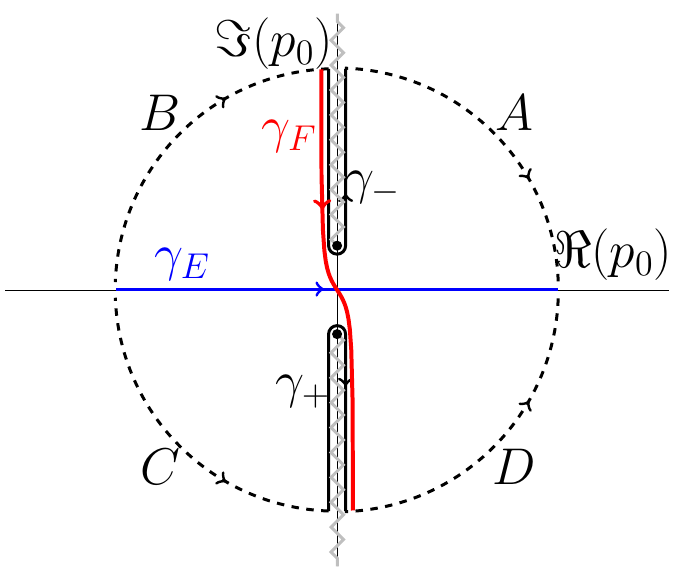
Figure 4 . Contour for would-be \Wick rotation" in the presence of branch-cuts, where p 0 is real for the Euclidean case. (cid:13) E is the contour for the Euclidean propagator, while (cid:13) F is the contour for the (+ i(cid:15) ) Feynman propagator in Minkowski space. At in(cid:12)nity, the integrals for any propagator de(cid:12)ned as a function of p 2 , obey B = D = (cid:0) A (cid:3) and C = A . Equating the Euclidean propagator (cid:1) with the semi-circular integrals taken above and below the real axis gives (cid:13) (cid:0) = (cid:13) +